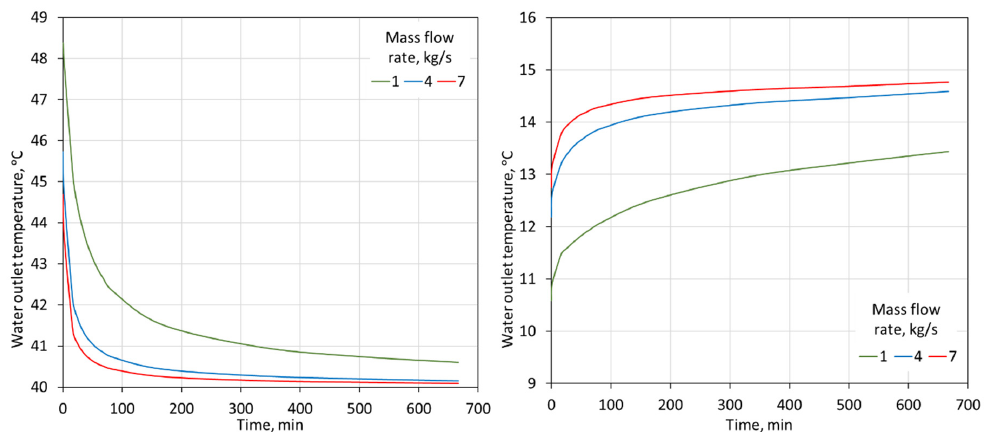
Figure 11. Water outlet temperature from two 2000-L tanks for 15–85% proportions of heating-PCM and cooling-PCM for heating (left) and cooling (right) modes for different water flow rates through the tanks.